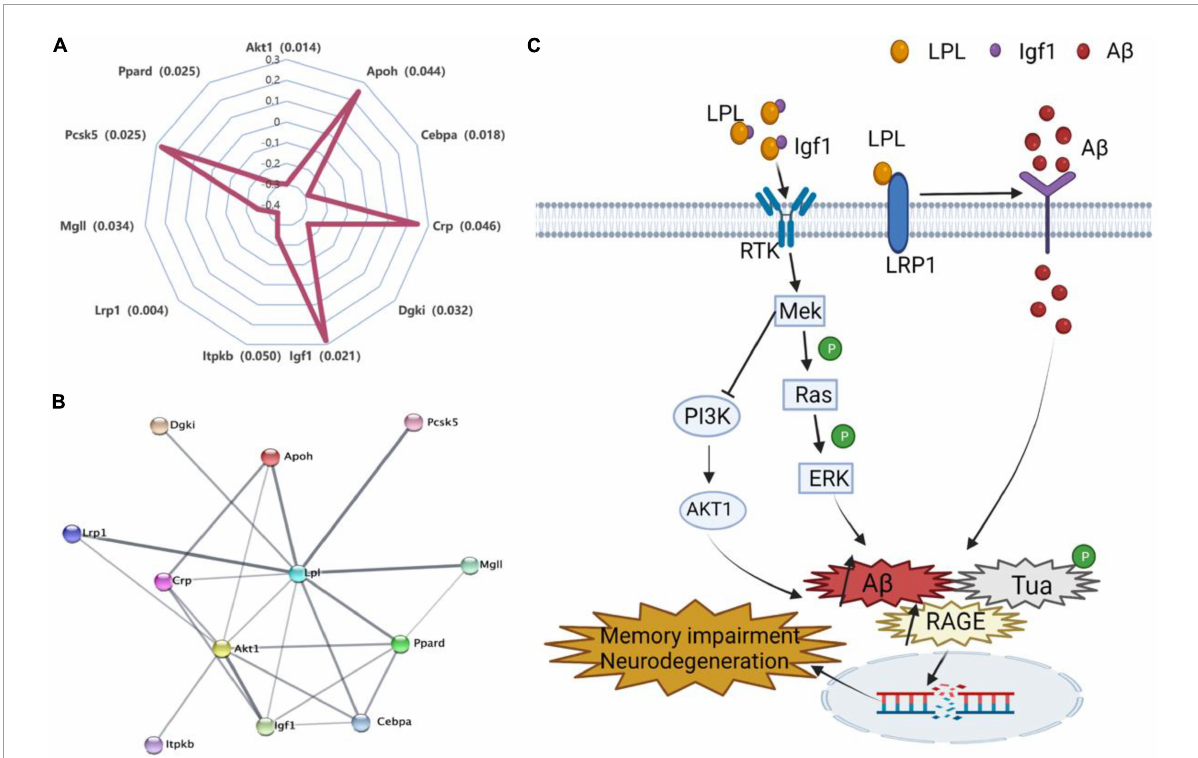
FIGURE6 Molecular mechanisms of Lpl involved in the regulation of cognitive dysfunction. (A) Correlations between the expression of Lpl and its directly interacted genes. The Pearson correlation coefficient was used to determine the relationship. (B) The Lpl PPI interaction network. The network was created and evaluated with the 11 Lpl directly interacted genes using string (https://www.string-db.org/). (C) Lpl interacts with Igf1 to activate the MAPK signaling pathway while blocking the PI3K/AKT1 signaling pathway, leading to amyloid β (A β ) toxicity, increased RAGE expression, tau hyperphosphorylation, induction of apoptosis, and autophagy. Lrp1 regulates A β binding and uptake in neurons and interacts with Lpl to activate the MAPK signaling pathway, inducing neuronal damage that leads to cognitive